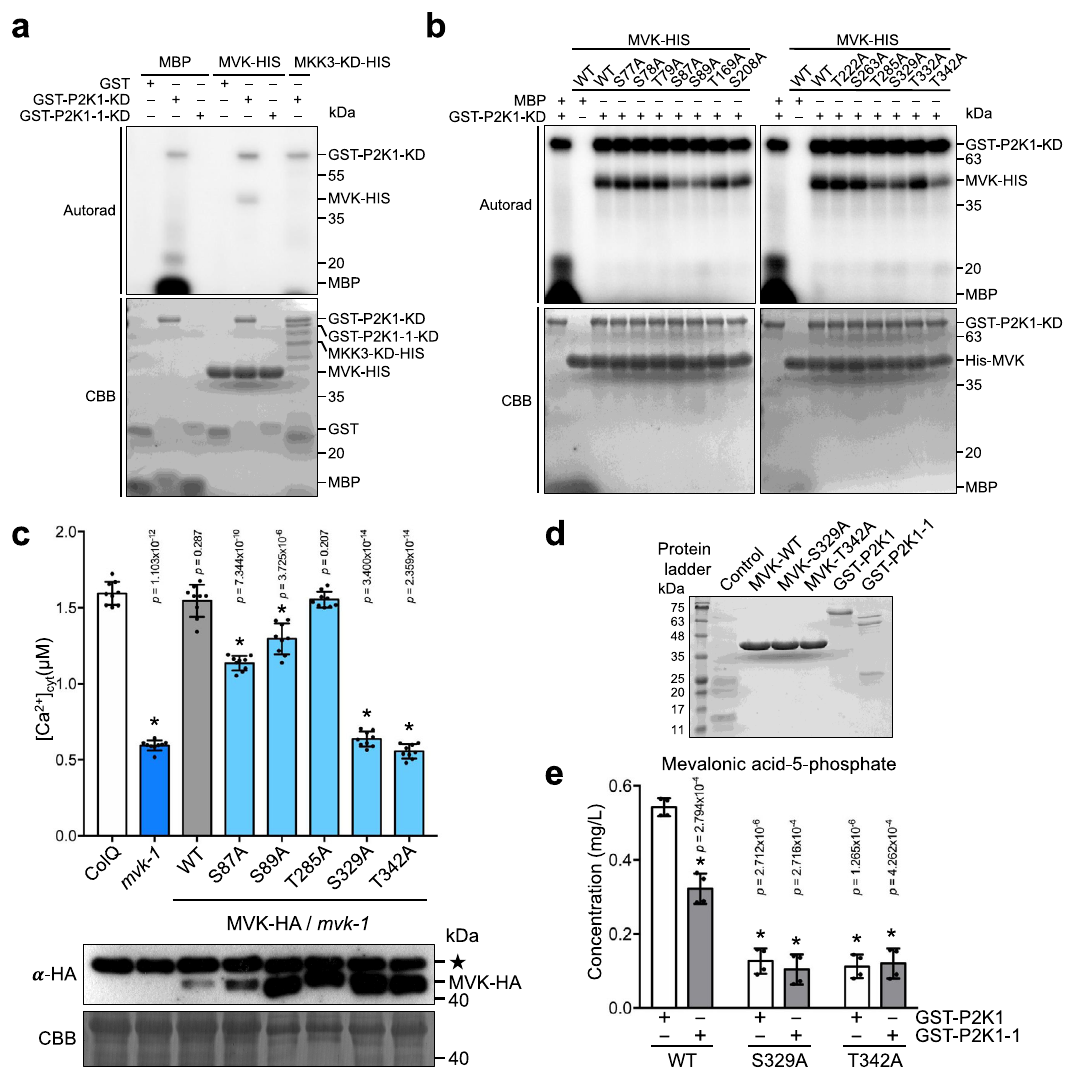
Fig. 6 P2K1 phosphorylates MVK in vitro. MVK residues S329 and T342 are required for ATP-triggered calcium production. a P2K1 phosphorylates MVK. Puri fi ed MVK-HIS recombinant protein was incubated with GST-P2K1-KD kinase domain, GST-P2K1-1-KD (kinase dead), or GST in an in vitro kinase assay. Autophosphorylation and trans-phosphorylation were measured by incorporation of γ -[32 P]-ATP. MBP and MKK3-KD-HIS kinase domain were used as positive and negative controls, respectively. Protein loading was visualized by Coomassie brilliant blue (CBB) staining. b P2K1 phosphorylates MVK and site-directed mutation of P2K1-mediated MVK phosphor sites. Puri fi ed MVK-HIS recombinant protein was incubated with GST-P2K1-KD kinase domain in an in vitro kinase assay. Autophosphorylation and trans-phosphorylation were measured by incorporation of γ -[32P]-ATP. MBP was used as positive control. Protein loading was visualized by Coomassie brilliant blue (CBB) staining. c MVK phosphor sites are required for ATP-triggered calcium production. The indicated constructs were expressed in the mvk-1 mutant background and treated with 100 μ M ATP. All data represented as means ± SEM, n = 9 seedlings (* P < 0.05, two-sided Student ’ s t test). See also the calcium kinetics shown in Supplementary Fig. 9b. Total MVK-HA protein was detected by anti-HA immunoblot. Star indicates nonspeci fi c band which was used as a loading control. d Recombinant MVK and P2K1 proteins. SDS-PAGE of HIS and GST tagged proteins isolated from E. coli cells expressing recombinant control (empty vector), MVK-WT-HIS, MVK-S329A-HIS, MVK-T342A-HIS, GST-P2K1-KD, and GST-P2K1-1-KD. Protein loading was visualized by coomassie brilliant blue staining. e Enzymatic activity of P2K1 and MVK-WT, MVK- S329A, and MVK-T342A proteins measured by UPLC-MS/MS. Data are shown as mean ± SEM. Asterisks indicate signi fi cant differences between WT and MVK proteins (S329A and T342A) with GST-P2K1 or GST-P2K1-1. ( n = 4 biological replicates, * P < 0.01, two-sided Student ’ s t test). All above experiments were performed and analyzed three times with similar